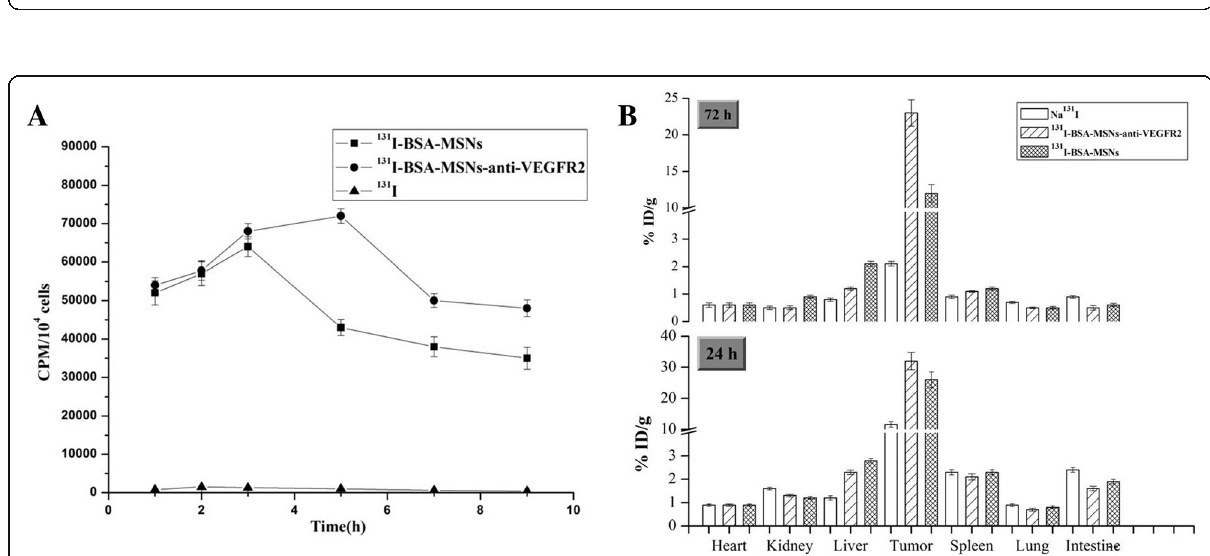
Fig. 2 Uptake of constructed nanoparticles. Confocal laser scanning microscope images showed cellular internalization of different formulations at 1 and 6 h for BSA-MSNs and BSA-MSNs-anti-VEGFR2. The florescent signal at 1 h was increased at 6 h for both groups. Additionally, the binding green fluorescence in the anti-VEGFR2-targeted group was stronger than that in non-targeted group at both time points